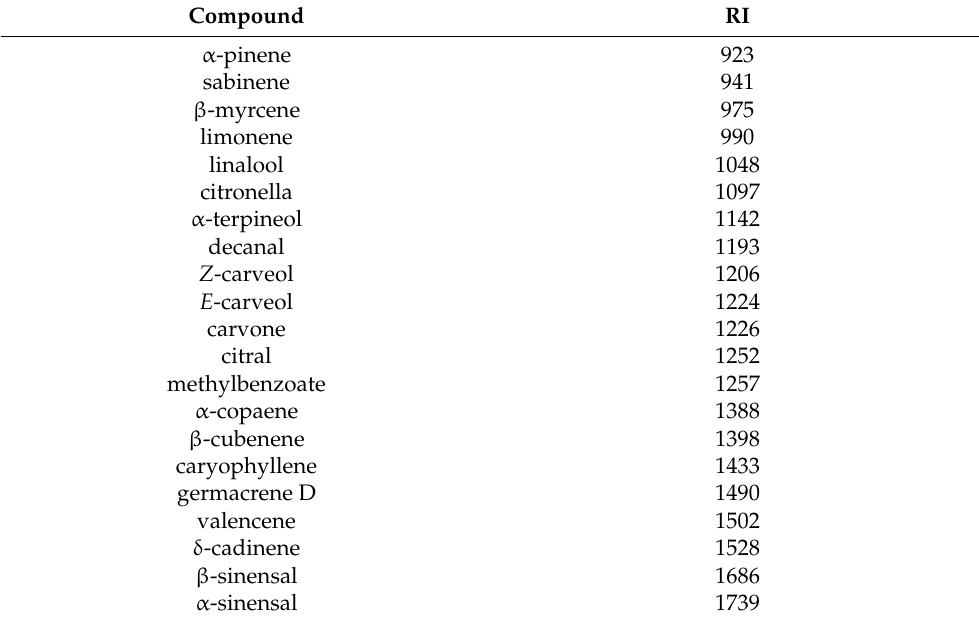
Table 1. Volatile compounds of cold-pressed orange essential